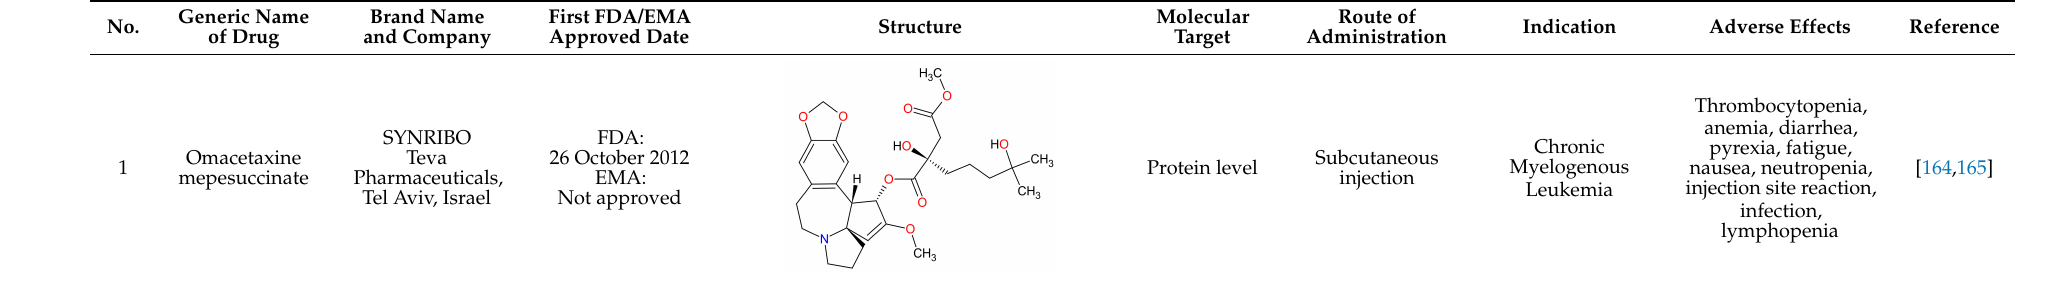
Table 7. Features of the protein translation inhibitor approved by the Food and Drug Administration (FDA) from 2011 to